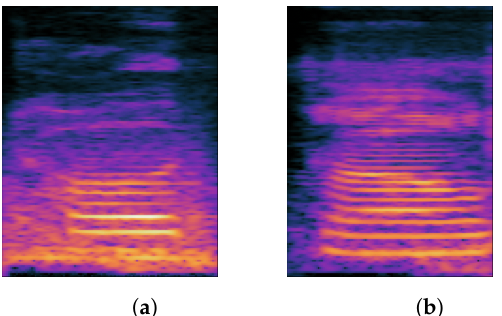
Figure 3. Spectrum comparison of FCDP and correct: ( a ) FCDP; ( b ) correct.